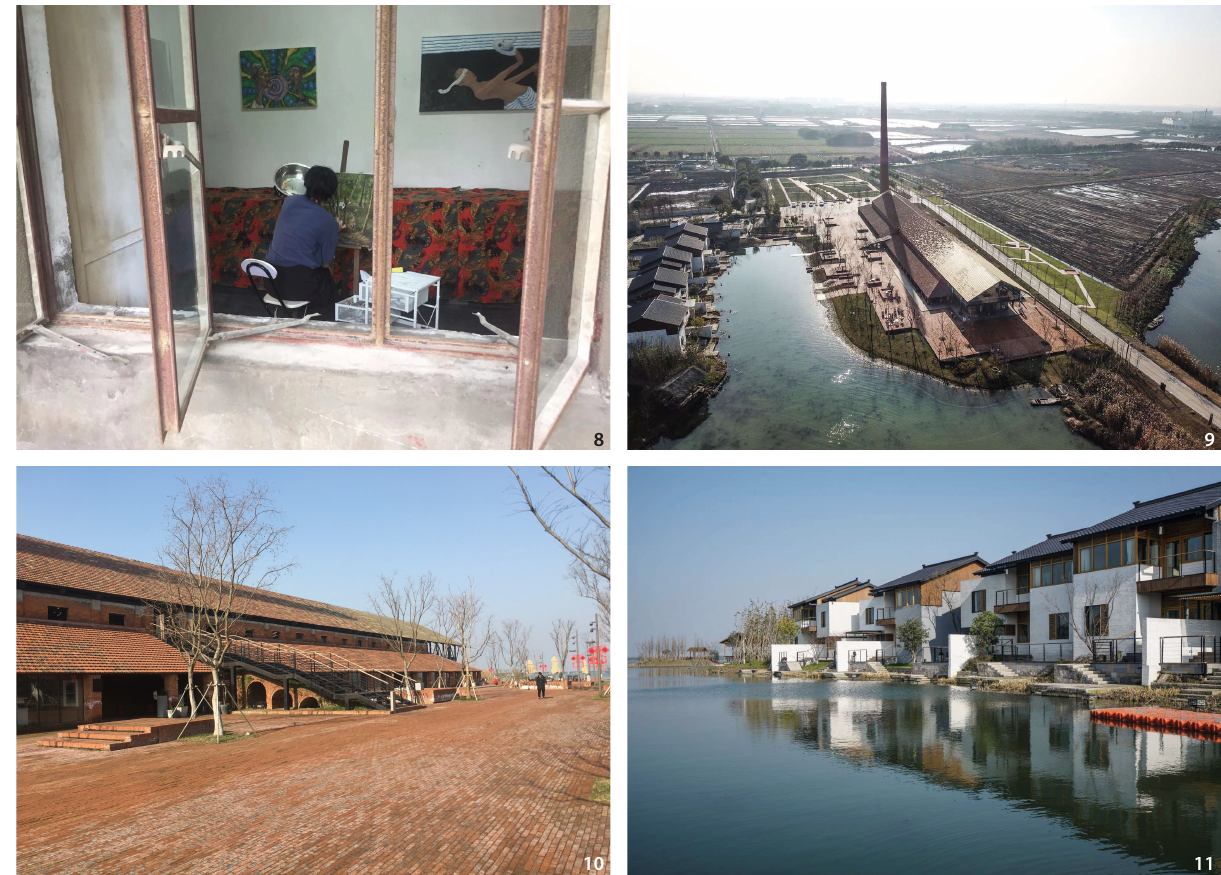
Figure 8 Artists in the art studio in Sanniaocang (Source: Jun Guo). Figure 9 Bird view of the Zhujiadian Brick Kiln Museum, BNBs and the village (Source: Jiayi Li). Figure 10 Exterior of the Zhujiadian Brick Kiln Museum (Source: Jiayi Li). Figure 11 BNBs near the Museum (Source: Jiayi